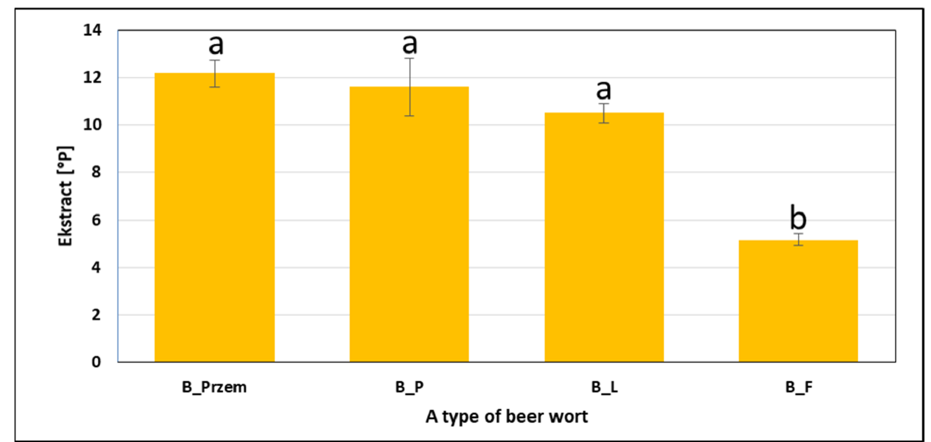
Figure 3. Beer wort extract (n = 5, α = 0.05; homogeneous groups of results within a given parameter are indicated with letters).